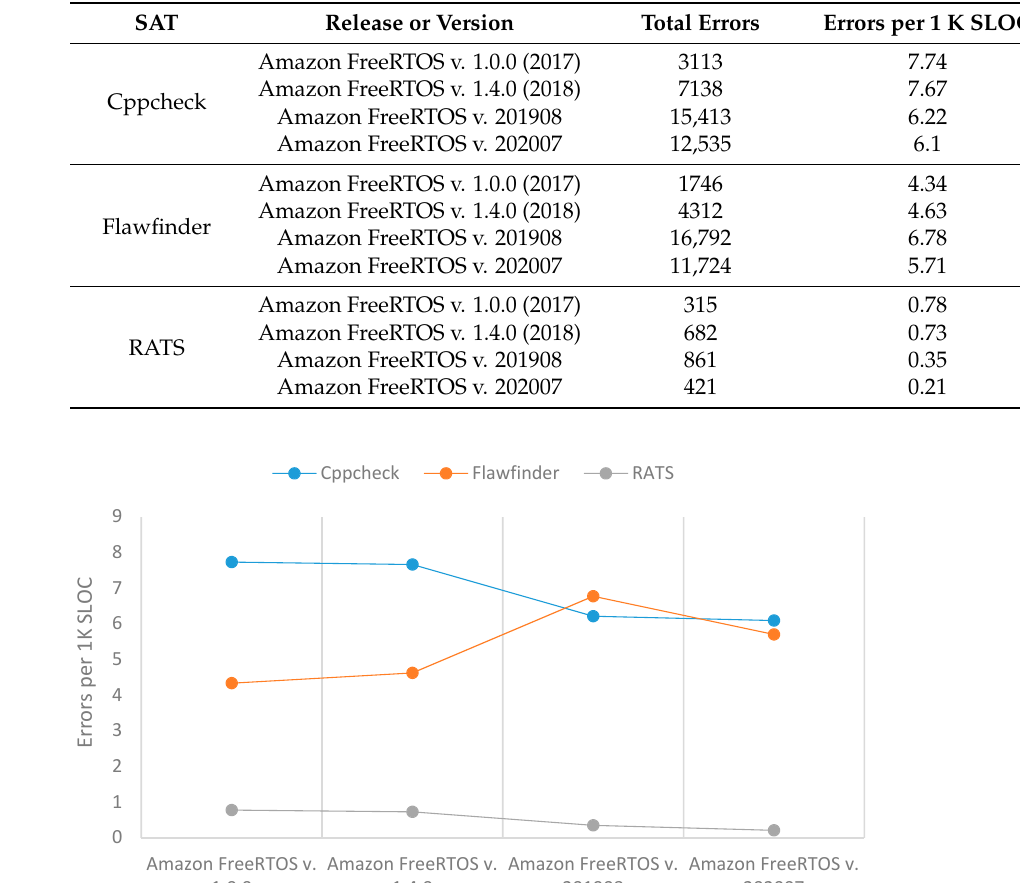
Figure 7. Errors per 1K SLOC of Amazon FreeRTOS. Table 7. Total errors and errors per 1K SLOC of Amazon FreeRTOS.